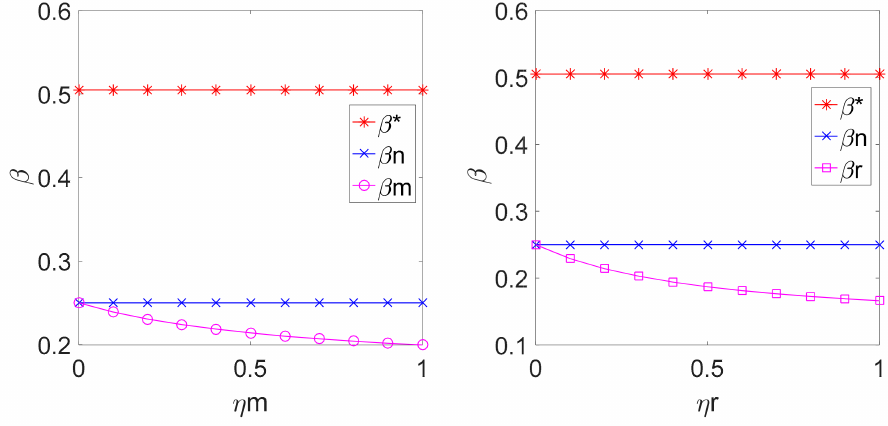
Figure 3. Relationship among η m , η r and β .